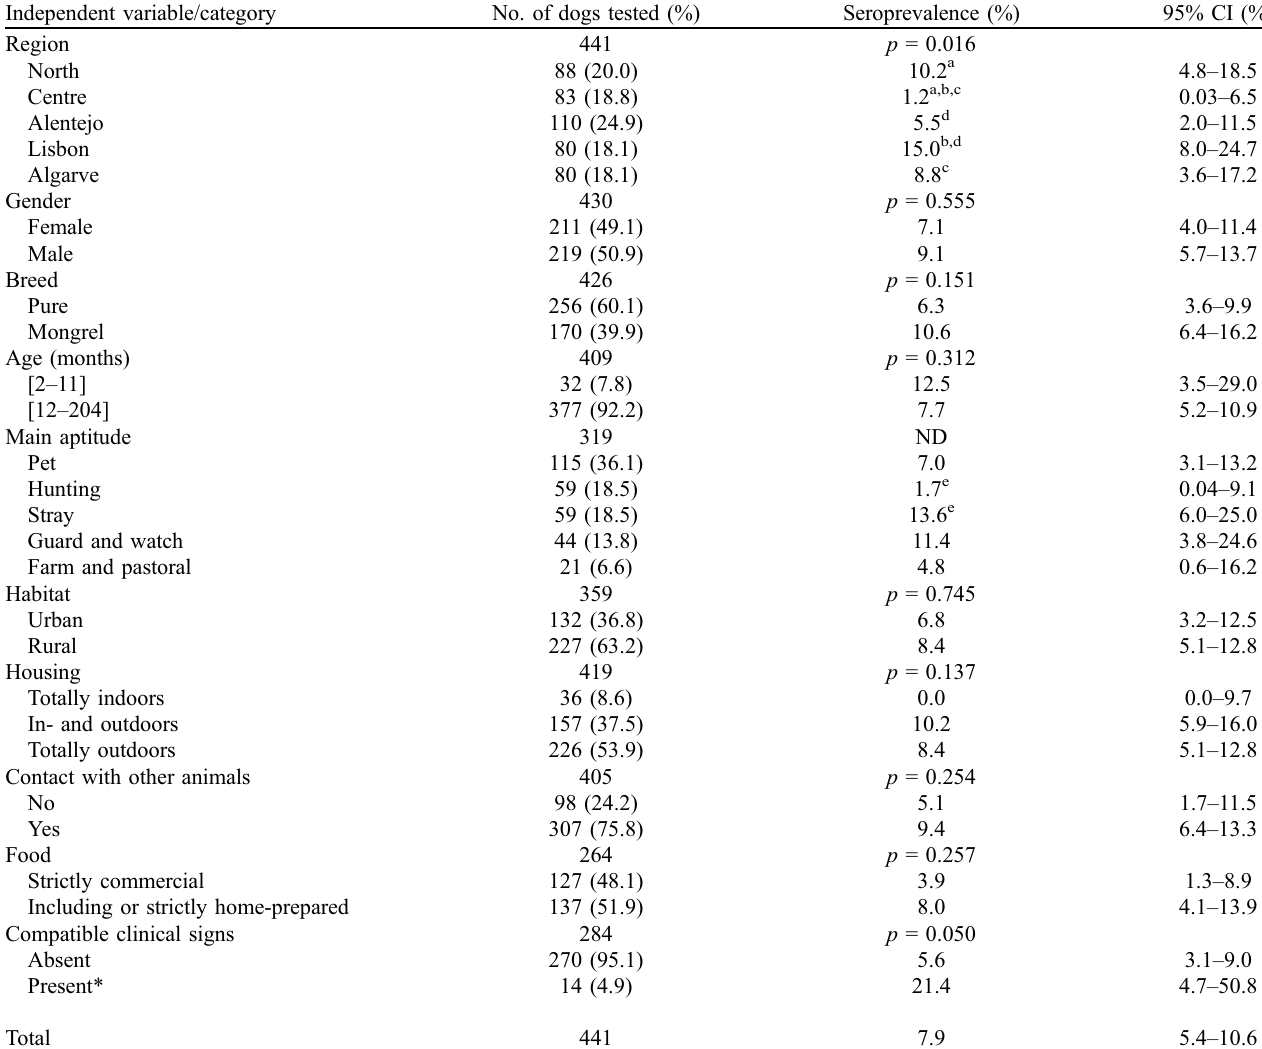
Table 1. Prevalence of antibodies to Neospora caninum in dogs from Portugal as determined by a competitive ELISA. Independent